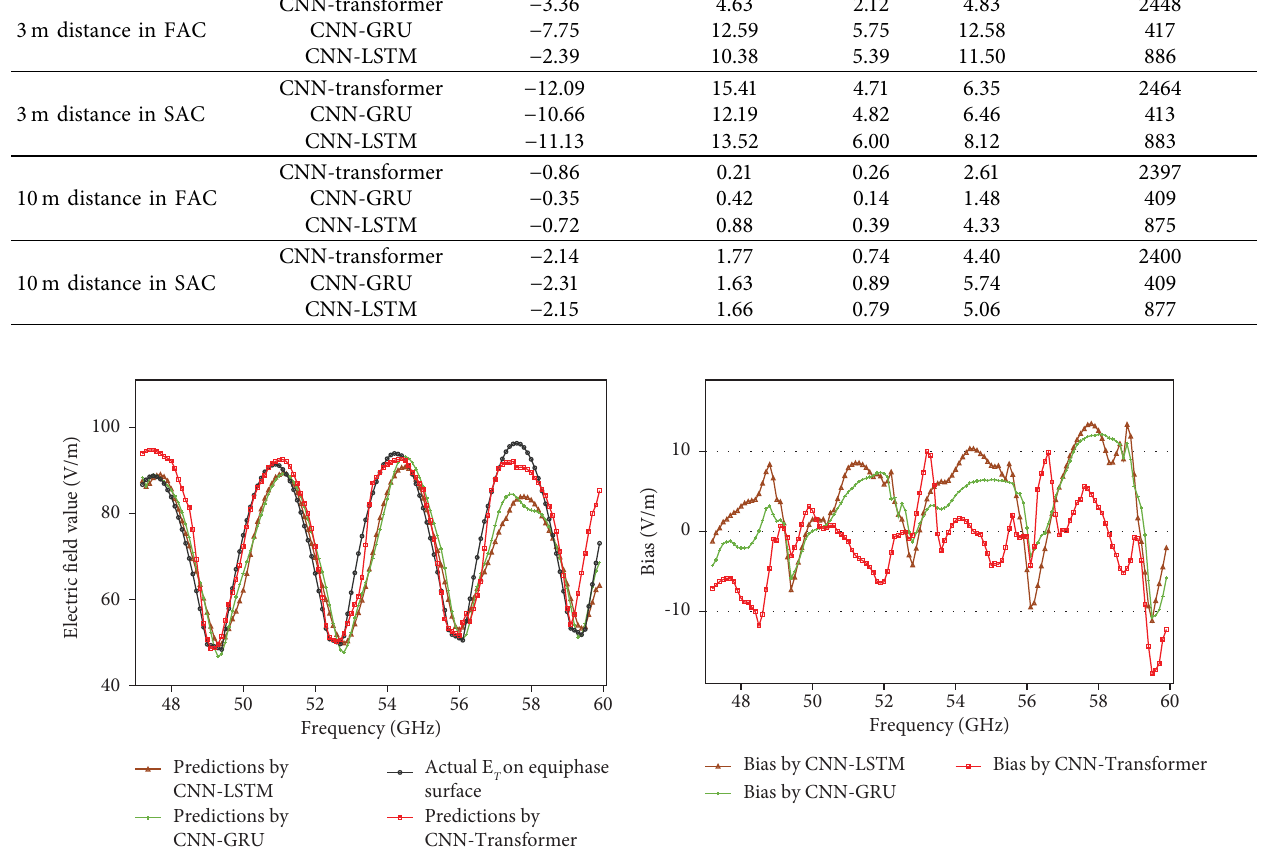
Figure 10: (a) Prediction results of a vertical dipole measured in a SAC: length h � 2U and 6U, distance d � 3 m. (b) Deviation in the predicted results and the actual electric feld on the equiphase surface.